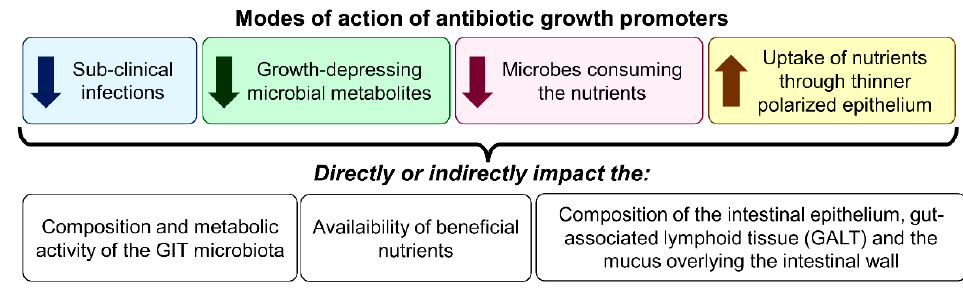
Figure 2. Proposed modes of action of antibiotics as growth promoters.